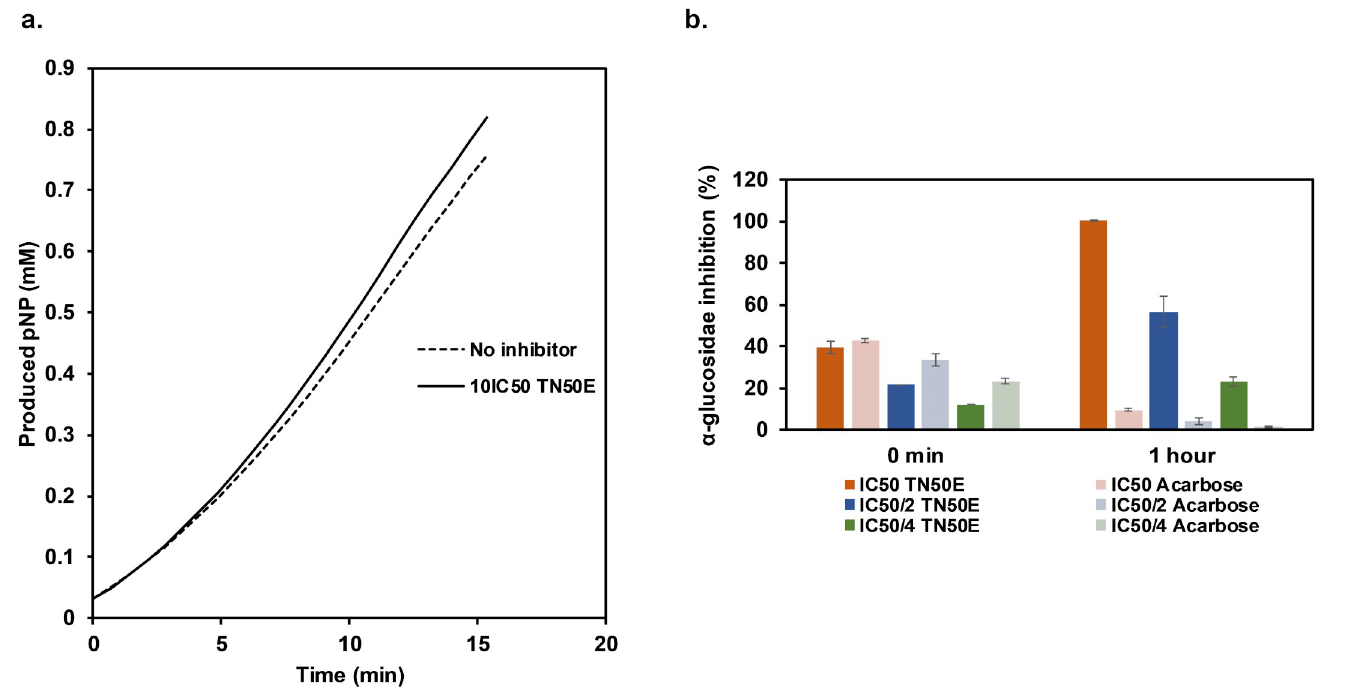
Fig 3. Reversibility of α -glucosidase inhibition and effect of pre-incubation. (a) Reversibility of α -glucosidase inhibition determined by rapid dilution assay. Produced pNP (mM) was determined after incubation of the enzyme in the absence (no inhibitor) or presence of TN50E extract. Initial rates were measured for 15 min after dilution of the enzyme-inhibitor complex with substrate to initiate the reaction. (b) α -glucosidase inhibition in the presence of IC 50 , IC 50 /2 and IC 50 /4 ( μ g/mL) of TN50E extract or acarbose before and after 1 h of pre-incubation with inhibitor. Mean values are presented and bars represent standard deviations.